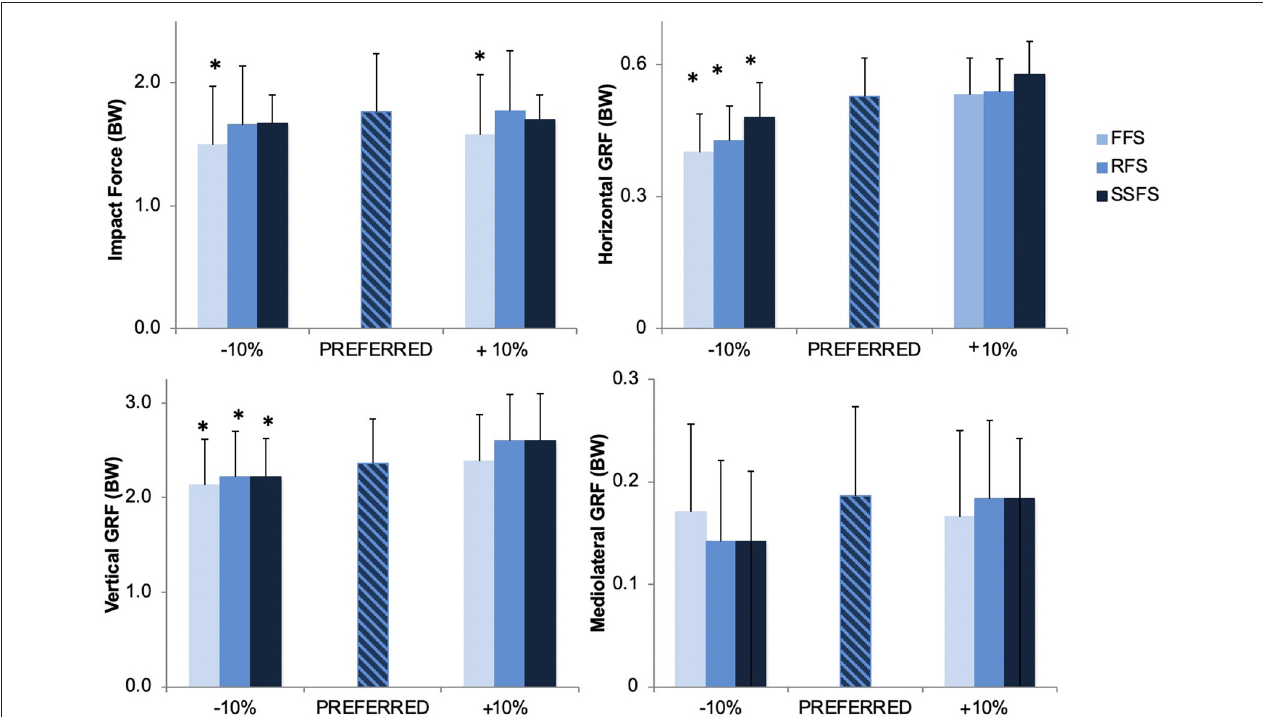
FIGURE 4 | Ground reaction force components for running in the stride length and foot strike manipulated trials. *Indicates a significant difference from preferred condition, p ≤ 0.05.